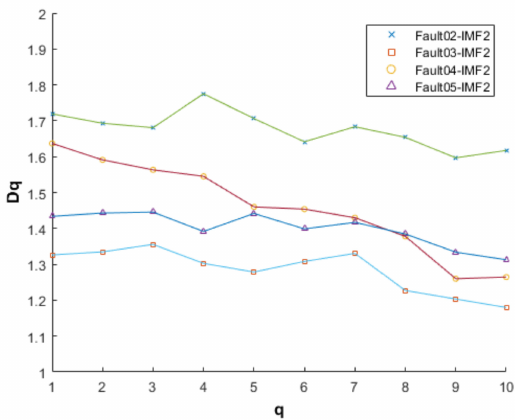
Figure 16. IMF2‑EMD mathematical morphology fractal dimension map.